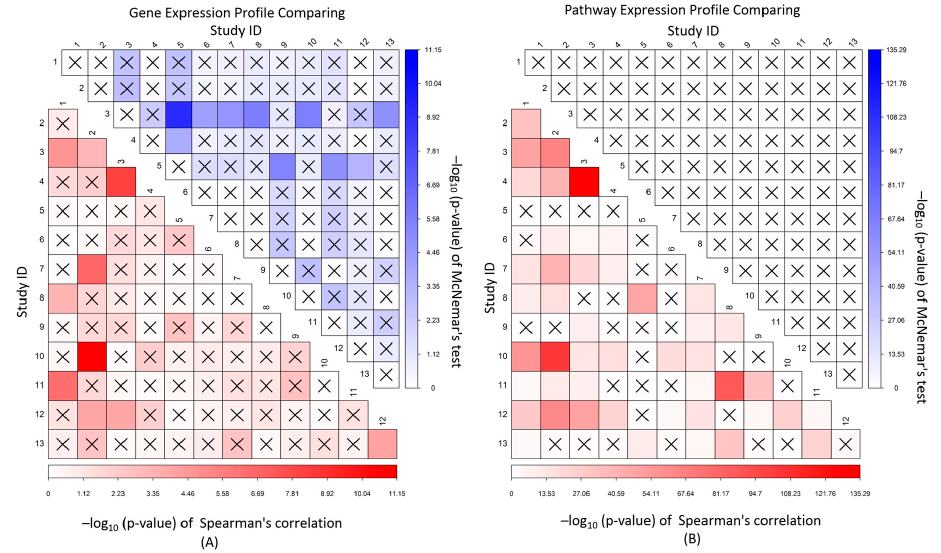
Figure 1. Correlation and independent analyses of gene ( A ) and pathway ( B ) expression association profiles between studies. The lower triangle is the correlation analysis and the upper triangle is the independent test. The ‘X’ indicates the analysis p ‐ value is not significant.